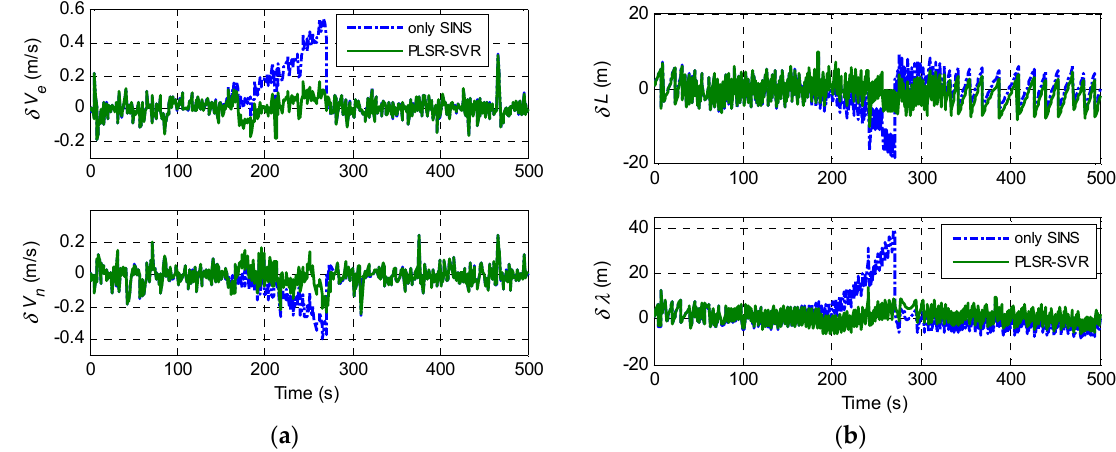
Figure 12. Navigation errors when there is a malfunction for a length of 120s: ( a ) Velocity errors; ( b )